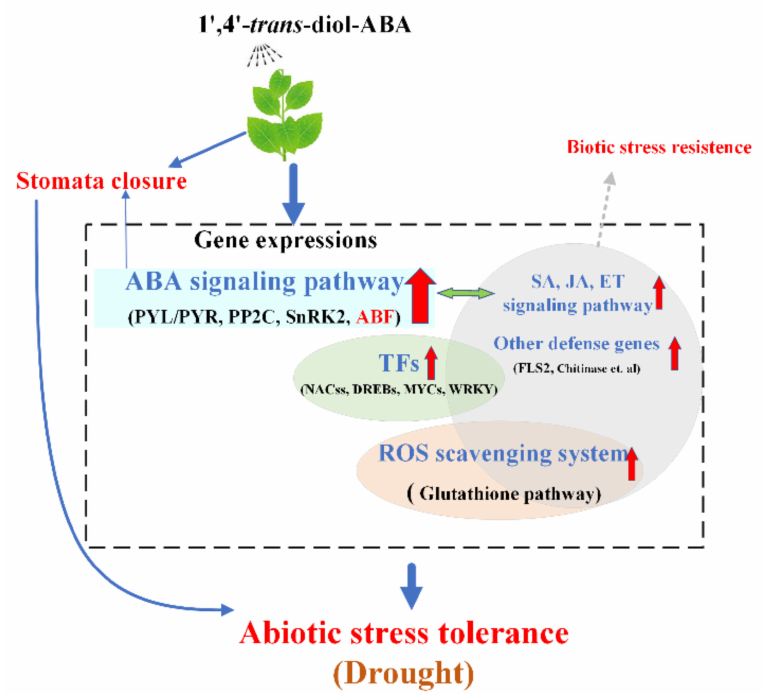
Figure 10. The summary about 1 (cid:48) ,4 (cid:48) - trans -diol-ABA inducing stress tolerance by affecting the level of gene expressions in tobacco. The red upward arrows indicate that the genes are up-regulated